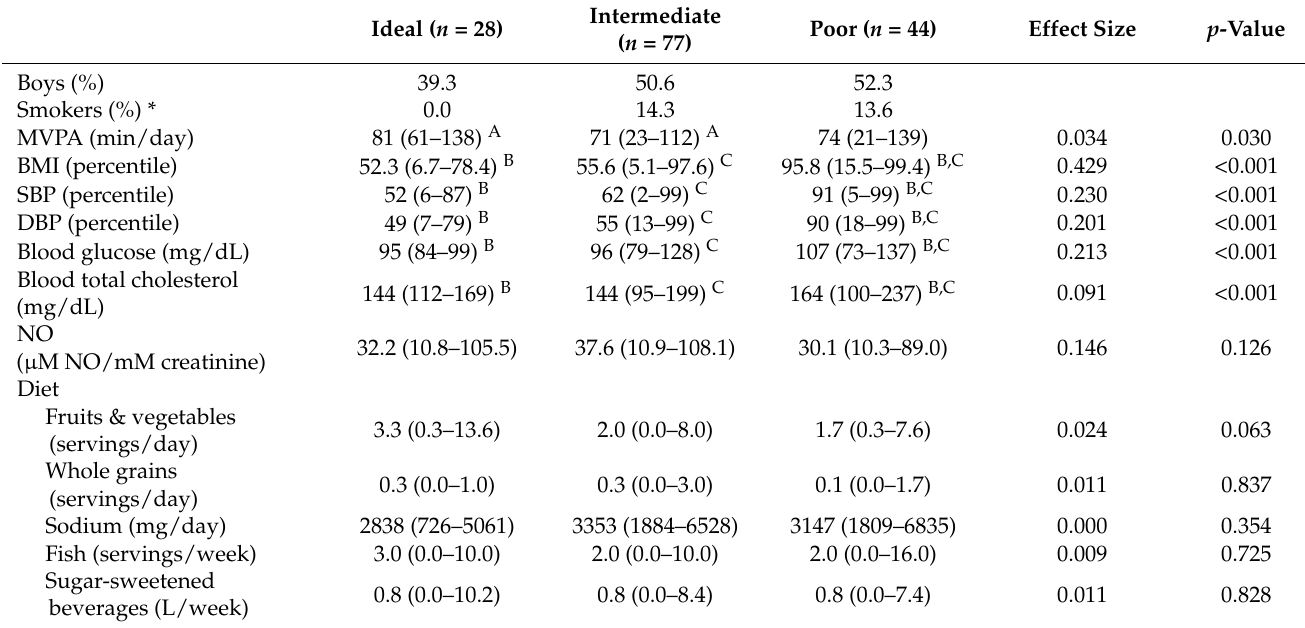
Table 2. Categories of cardiovascular health